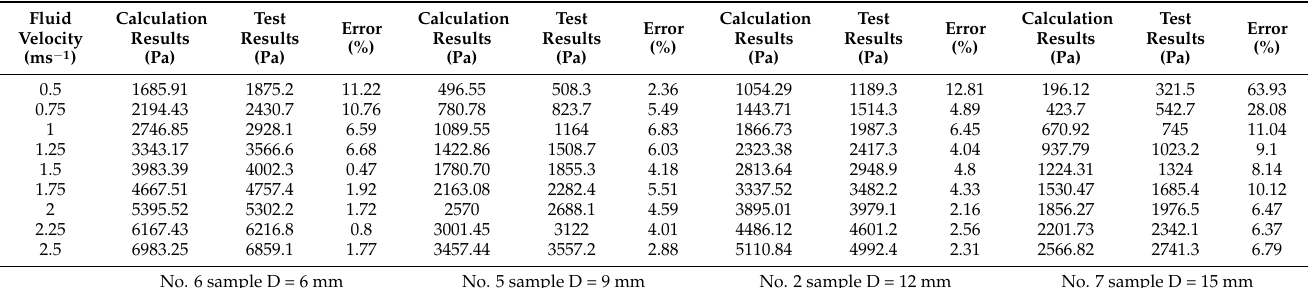
Table 8. Comparison between the test results of the flow channel samples and the calculation results of the mathematical